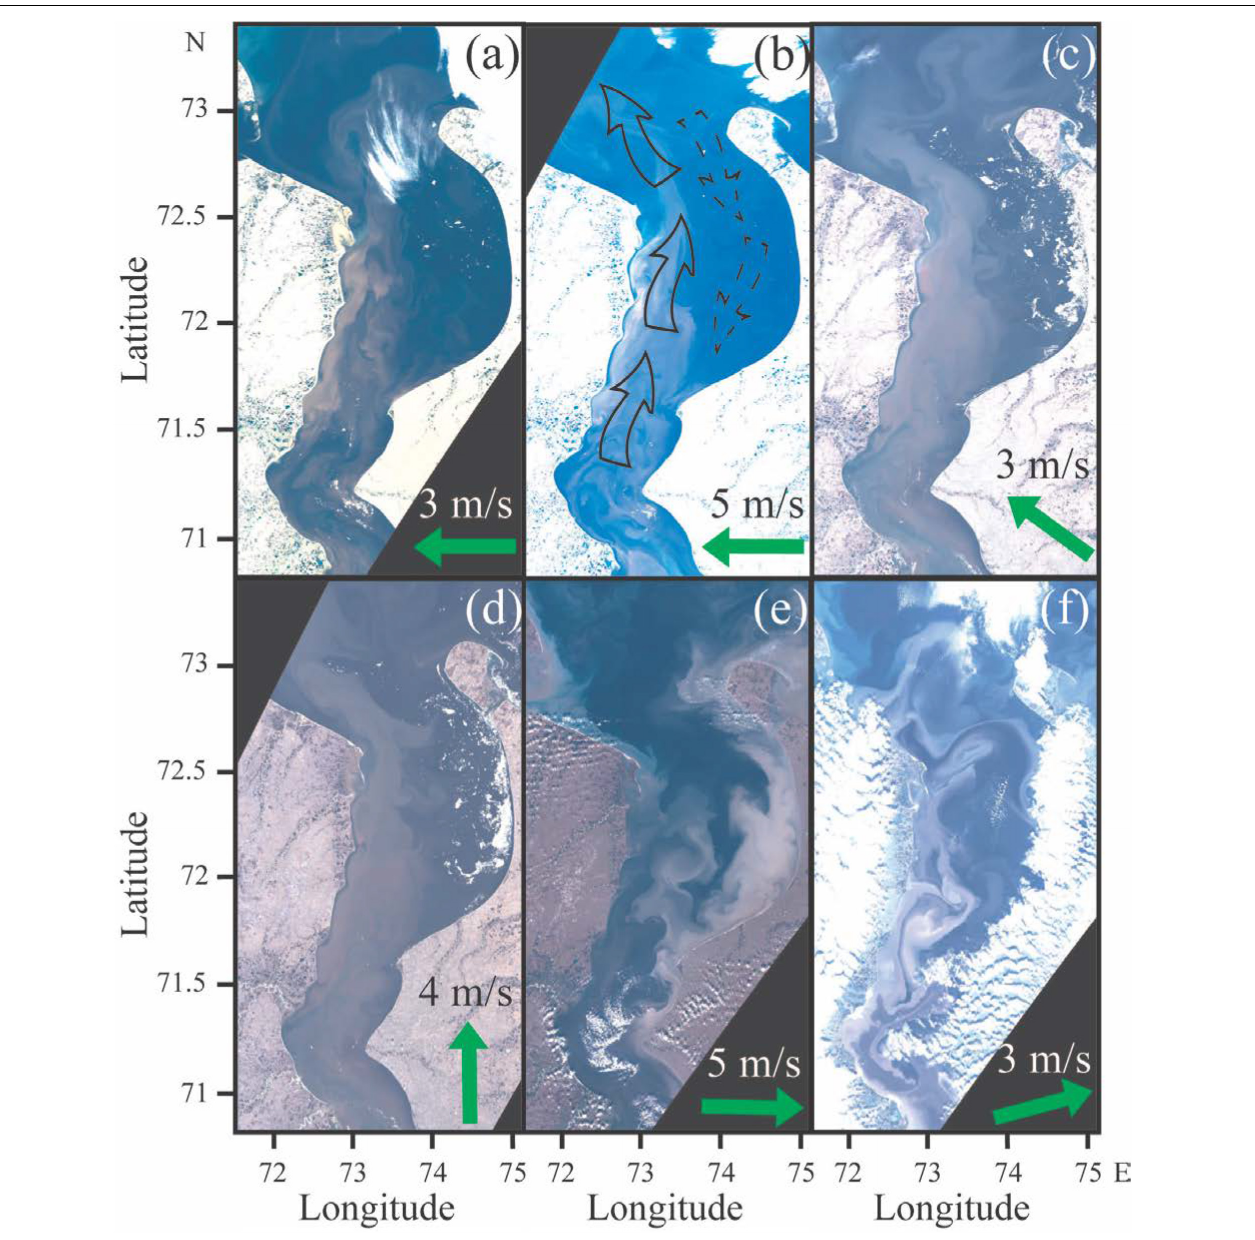
FIGURE 3 | Sentinel-2 optical satellite images of the northern part of the Gulf of Ob acquired on July 4, 2016 (a) , July 7, 2016 (b) , July 7, 2017 (c) , July 16, 2017 (d) , September 6, 2018 (e) , and August 16, 2020 (f) . Green arrows indicate wind forcing during the observation periods. Solid black arrows in panel (b) indicate the flow of riverine water from the gulf to the open sea, and dashed black arrows indicate the flow of saline water from the open sea to the